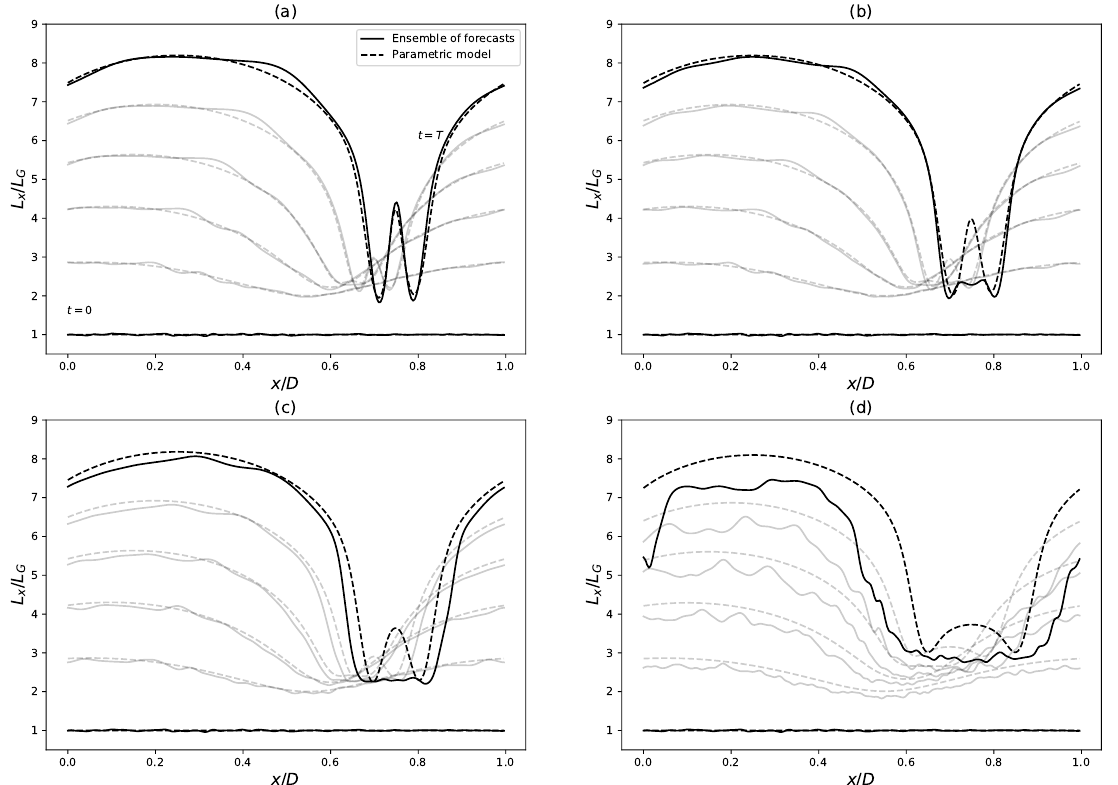
Figure 6. Parametric (dashed line) vs. ensemble estimated (continuous line) length-scale field for initial standard deviations σ 0 (b) (weakly nonlinear dynamics), σ 0 gent linear dynamics), σ 0 10% t = { 0 , 0 . 2 , 0 . 4 , 0 . 6 , 0 . 8 , 1 } T .